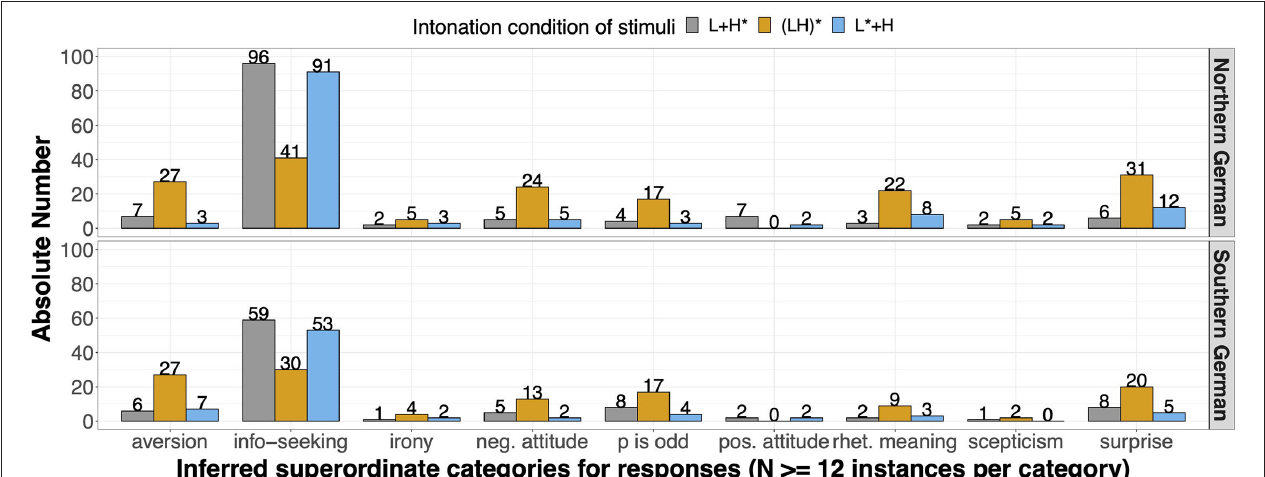
FIGURE 5 | Distribution of superordinate categories (inferred keywords from participants’ responses), color-coded for the different intonation conditions [L + H* in gray, (LH)* in orange, and L* + H in blue]; split by region [upper panel for speakers from Northern Germany ( N = 38 participants); lower panel for speakers from Southern Germany ( N = 28 participants)].